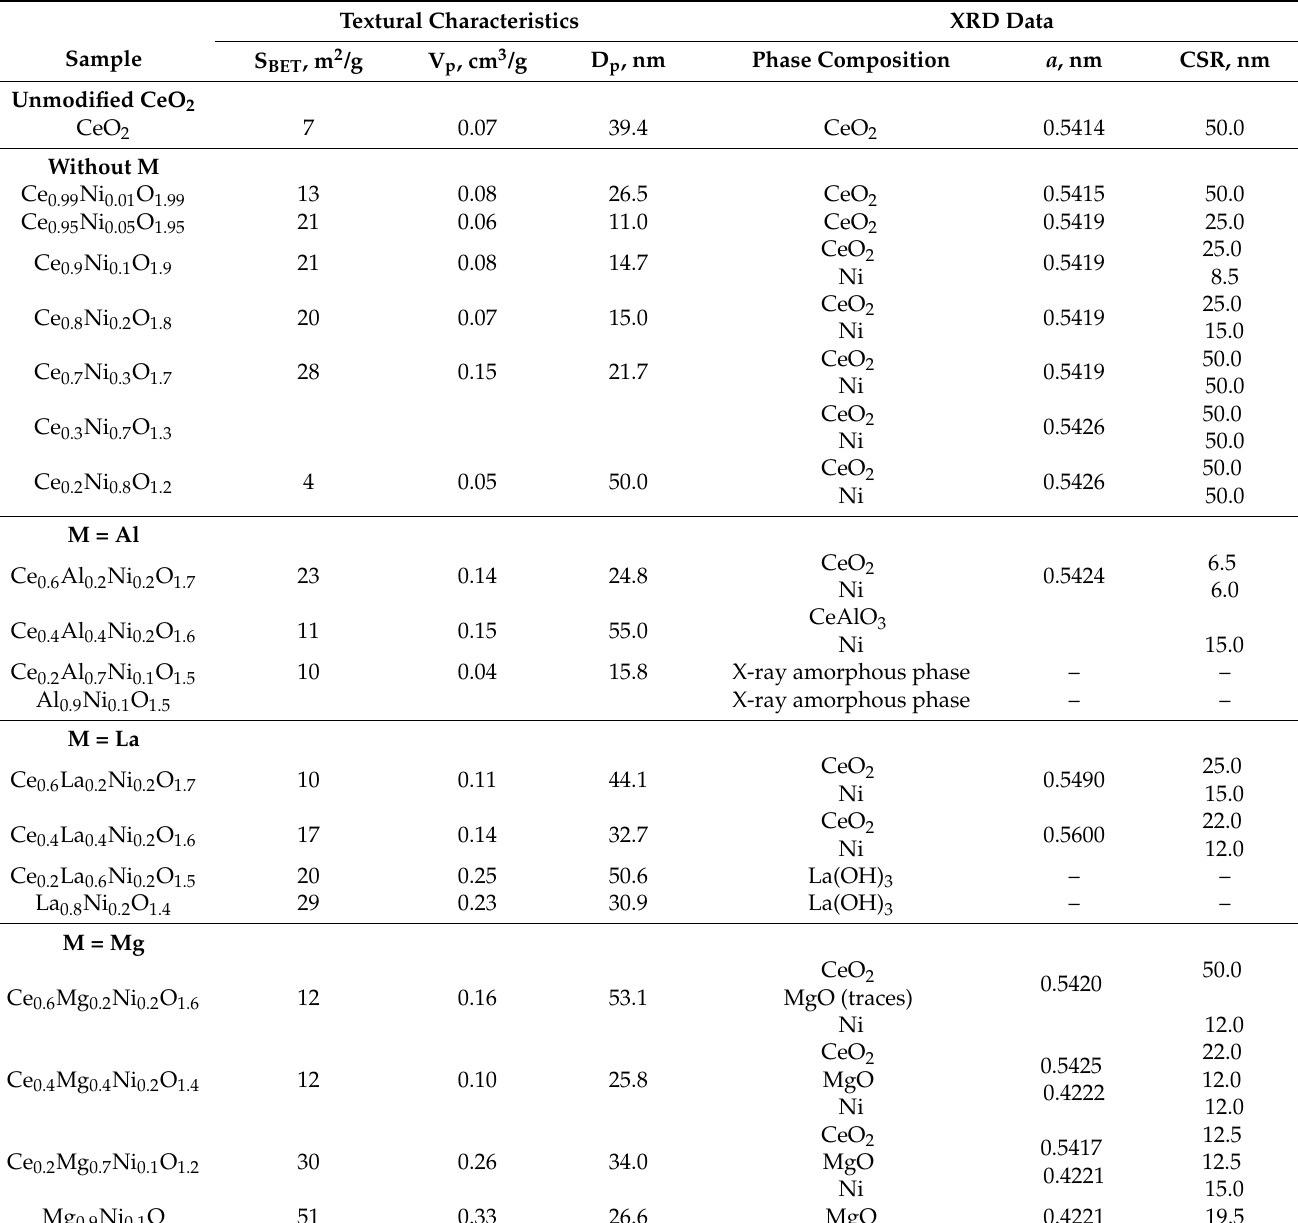
Table 3. Phase composition and structural properties of (CeM) 1 − x Ni x O y samples after